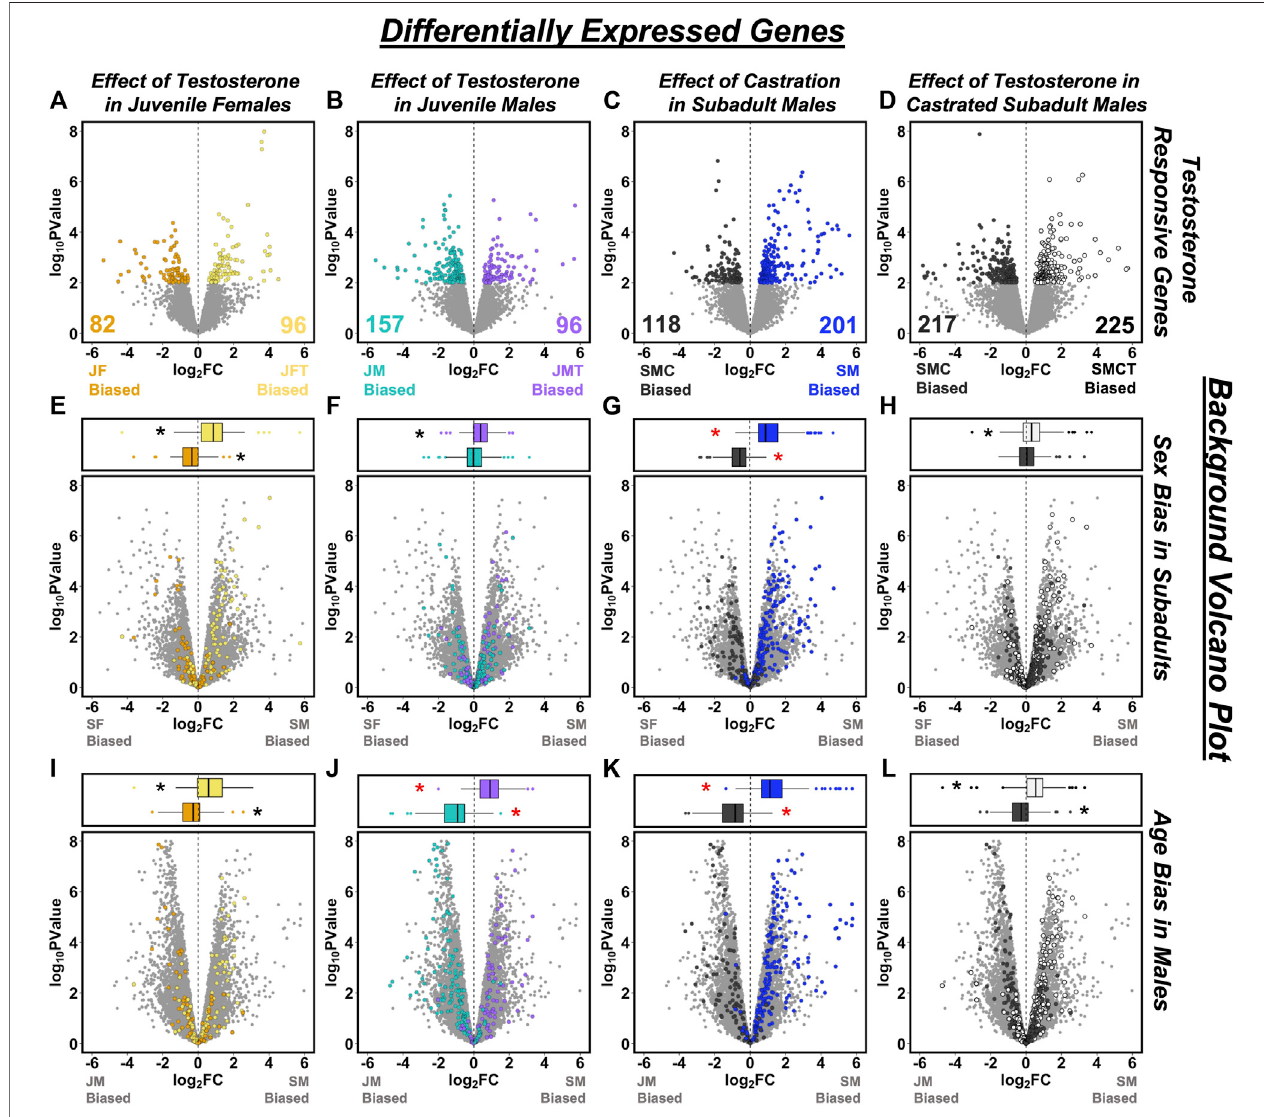
FIGURE 4 | Overlap between testosterone-responsive genes and patterns of sex- or age-biased expression. Volcano plots in the top row illustrate effects of testosterone on gene expression based on comparisons of (A) juvenile females with empty vs. testosterone implants (JF vs. JFT), (B) juvenile males with empty vs. testosteroneimplants (JMvs. JMT), (C) castrated vs. intact subadult males (SMC vs. SM), and (D) castratedsubadult maleswithempty vs. testosteroneimplants (SMC vs. SMCT).Differentiallyexpressed genes(DEGs, p < 0.01)areplottedincolorandothergenesareingray.Inthebottomtworows,testosterone-responsive DEGs from (A – D) are mapped onto plots describing (E – H) sex-biased expression in subadults, and (I – L) age-biased expression in males. Box-and-whisker plots above each panel report the median (line), upper 75% and lower 25% (box), and upper 95% and lower 5% (whiskers) for the log 2 fold change (FC) values of each category of DEG when mapped onto the corresponding volcano plot. Asterisks indicate mean log 2 FC values signi fi cantly different from zero following Bonferroni correction for multiple comparisons (adjusted p < 0.0031). Redasterisksindicatetests forwhichtheclassi fi cationofDEGsisnotstatisticallyindependentofthelog 2 (FC)valuesonthevolcano plot because the same group is included in each